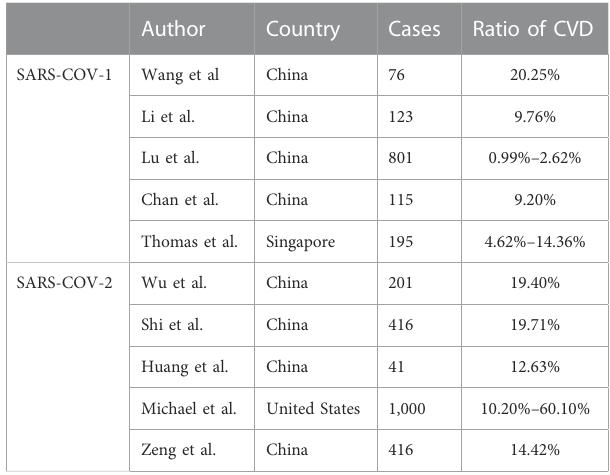
TABLE 2 Manifestations of viral cardiovascular